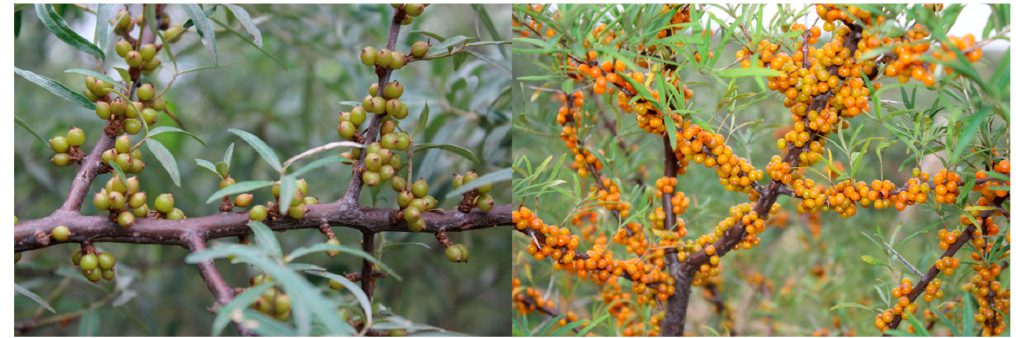
Figure 1. The fruit of sea buckthorn ( H. rhamnoides L.).